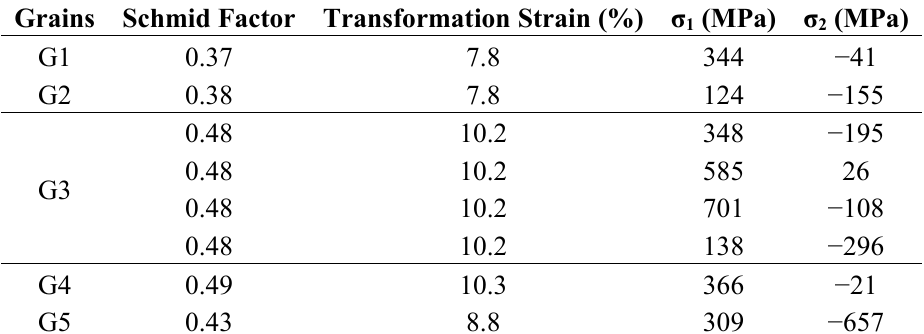
Table 1. Principal stresses (σ 1,2 ) measured at the grains of G1, G2, G3, G4, and G5 during loading to 8% strain.